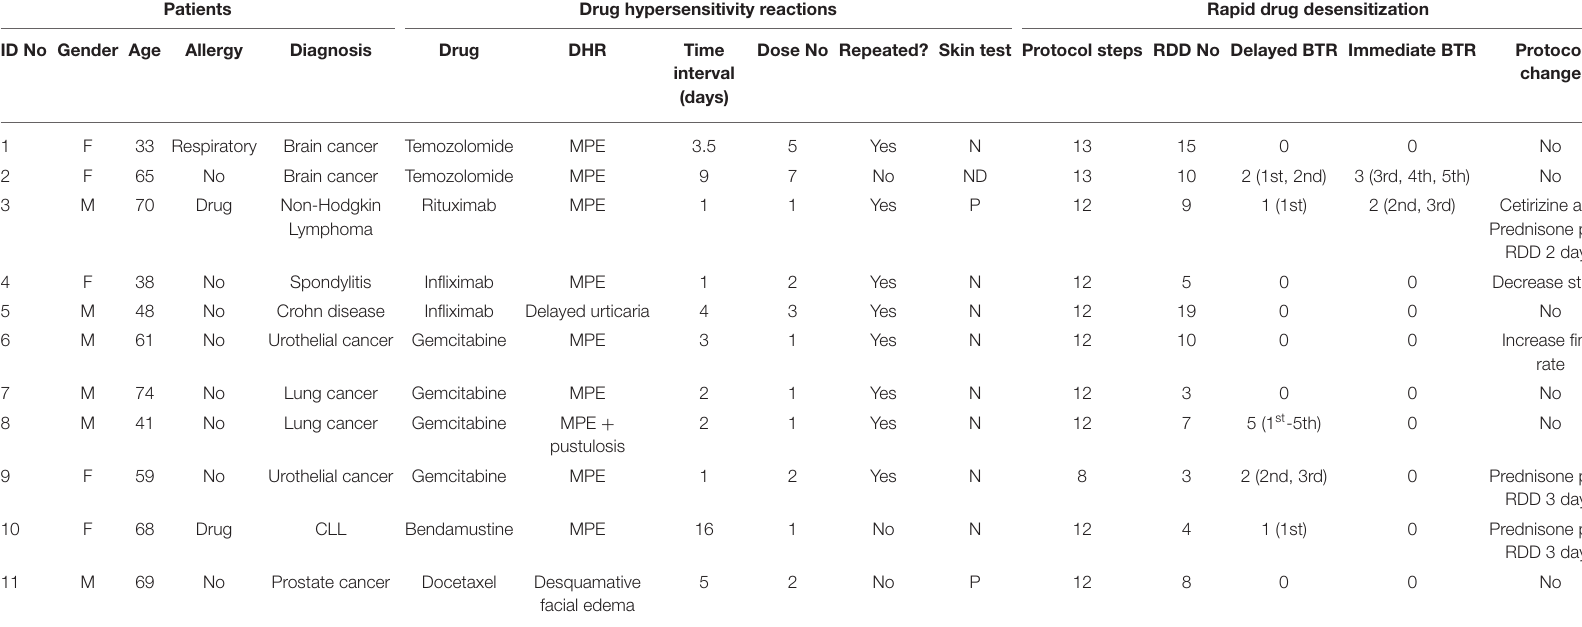
TABLE 1 | Patients characteristics. Patients Drug hypersensitivity reactions Rapid drug